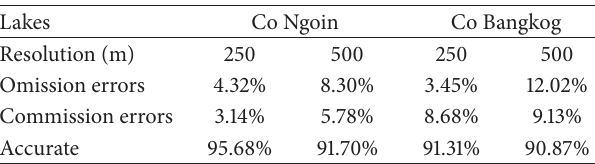
Table 3: Errors of water bodies derived from the original and downscaled MODIS SR images for Co Ngoin and Co